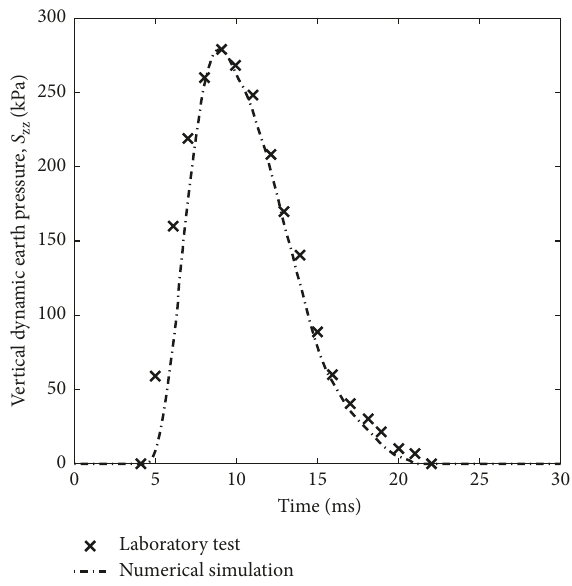
Figure 4: Time history of vertical dynamic